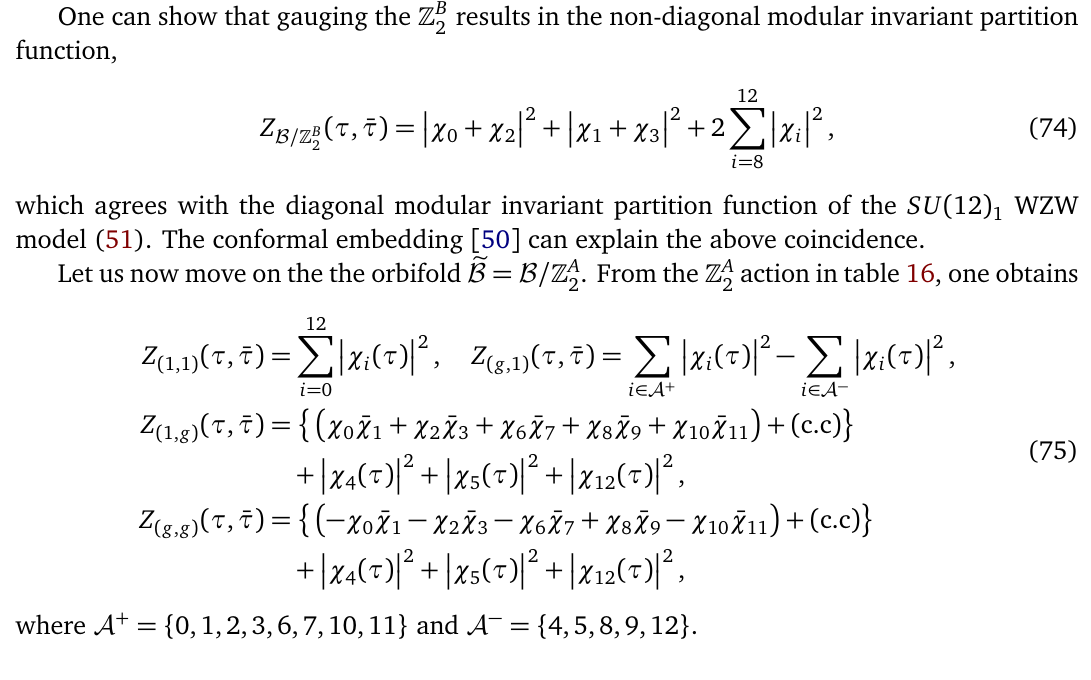
Table 16: SO ( 12 ) bels. Their characters are denoted by χ respectively. We highlight the primary related to the (cid:90)